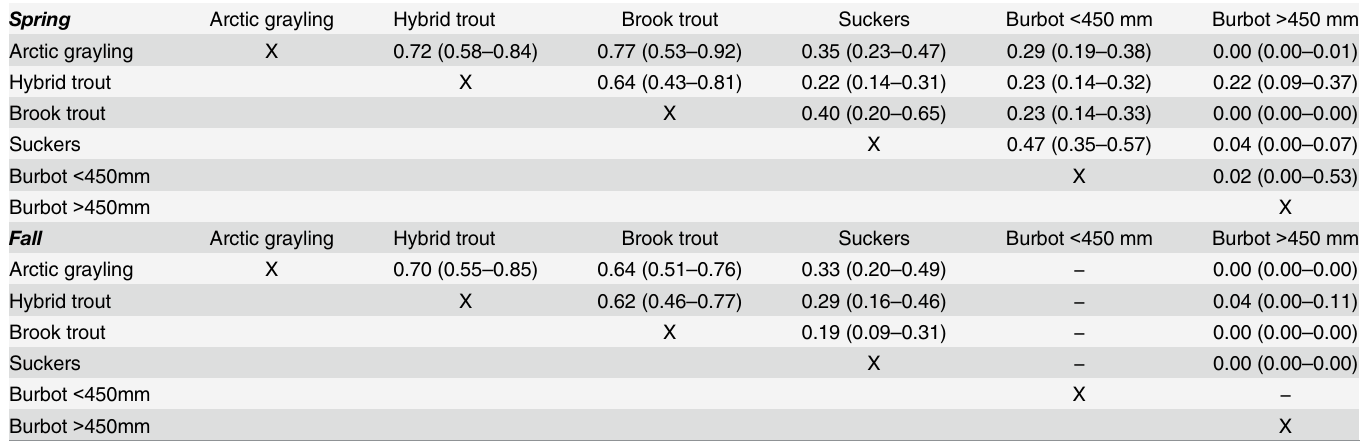
Table 1. Schoener ’ s index (1970,[45]) of trophic niche overlap among fishes. Values represent bootstrapped medians and 95% confidence intervals. ‘ − ’ signifies no